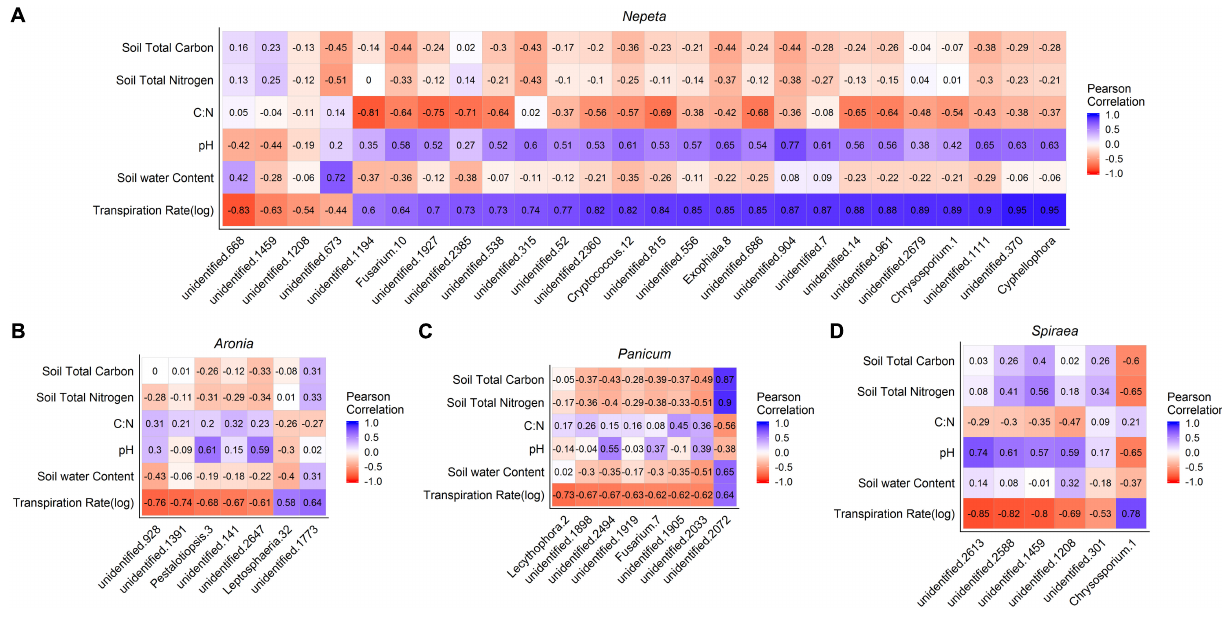
contribute to more dimensions of the multifunctional ecosystem services of